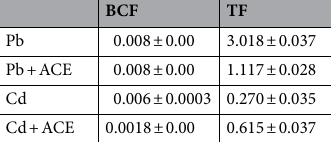
Table 3. Bioaccumulation and translocation factors of